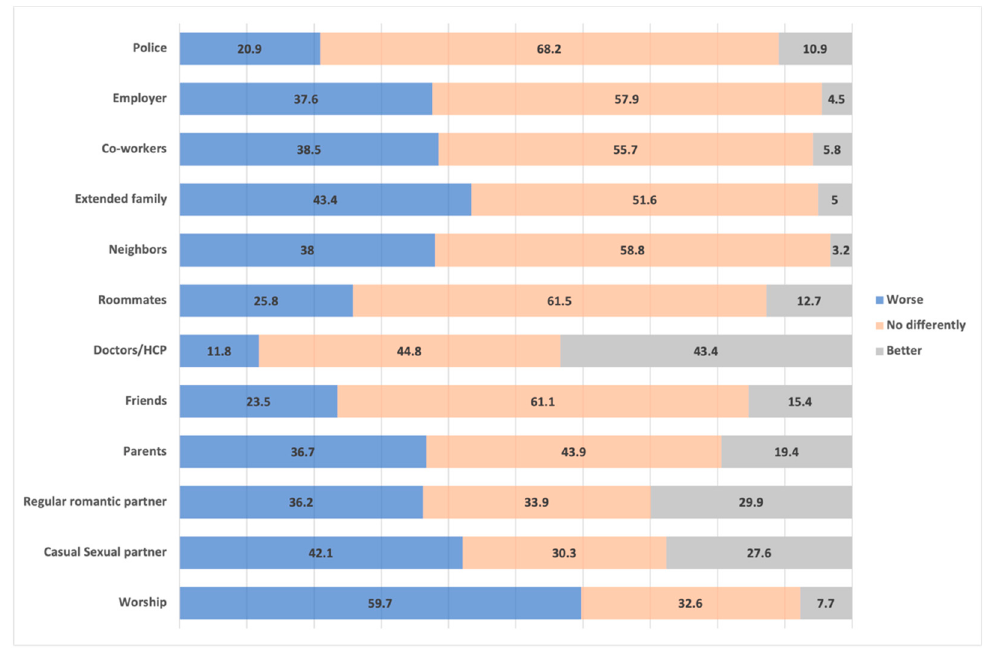
Figure 1. Percentage of participants who perceive they would be treated better, worse, or no differently by specific individuals or groups after disclosing they had been tested for an STI.